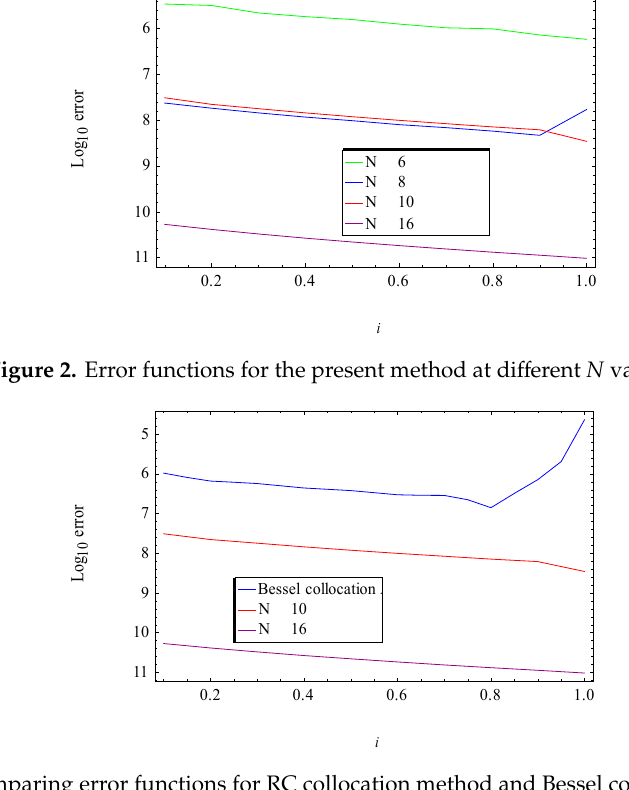
Figure 3 . Comparing error functions for RC collocation method and Bessel collocation method. Figure 3. Comparing error functions for RC collocation method and Bessel collocation